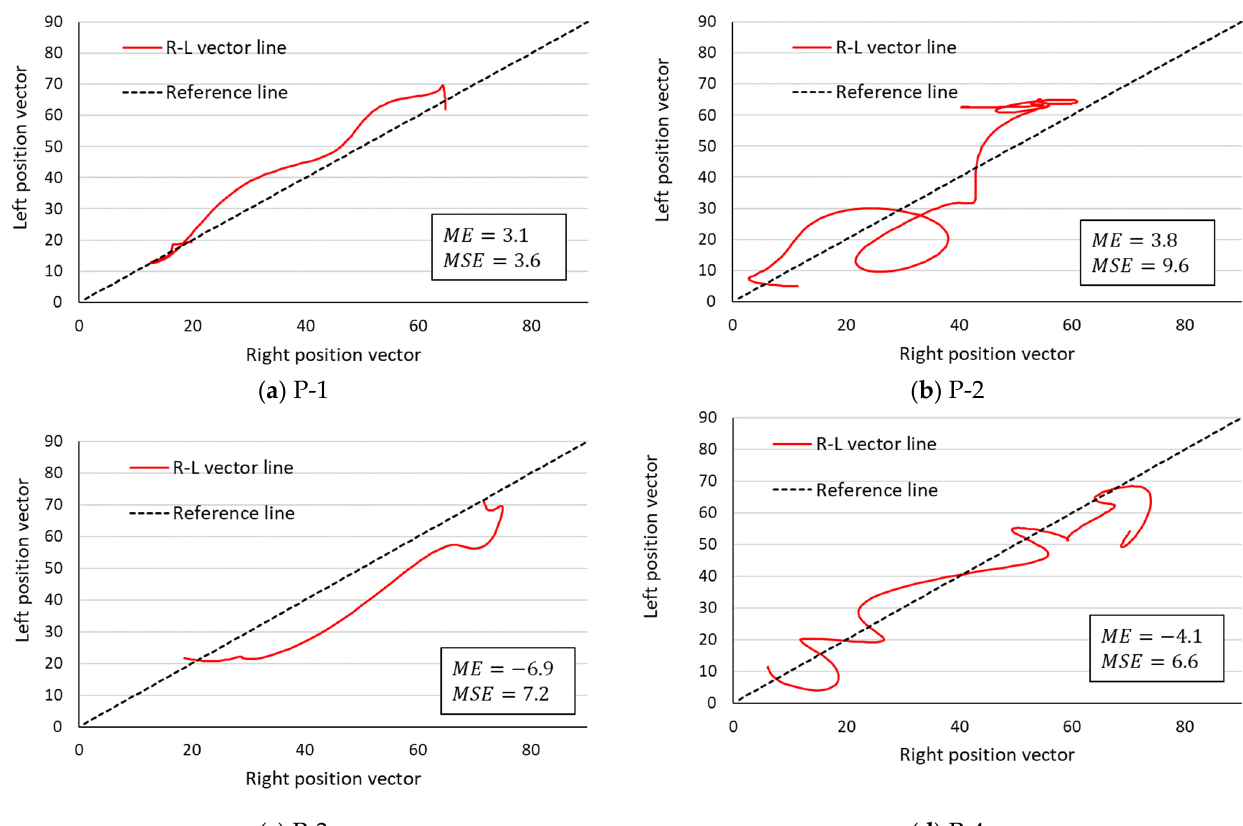
Figure 7. R–L vector line in the rehabilitation patient group. The lower limb movement pattern is symmetrical enough to be drawn near the central symmetry reference line. P-1 through P-4 in the figure refer to each rehabilitated patient in Table 1.